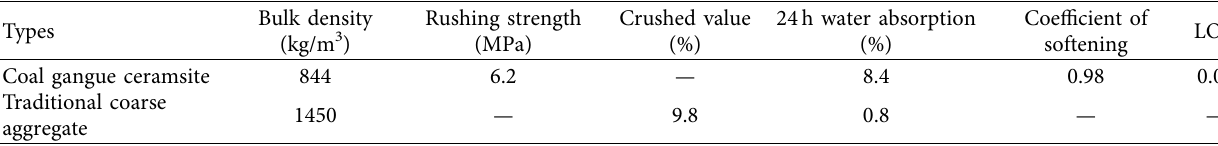
Figure 1: Coal gangue recycling: (a) coal gangue ceramsite; (b) production workshop. Table 1: Properties of the coarse aggregates.